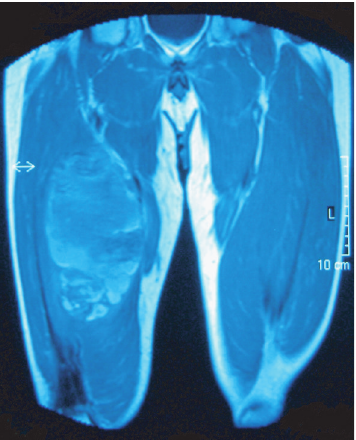
Figure 2: T1-weighted coronal spin-echo pulse sequence. Periph- eral high signal is seen within the entire lesion.